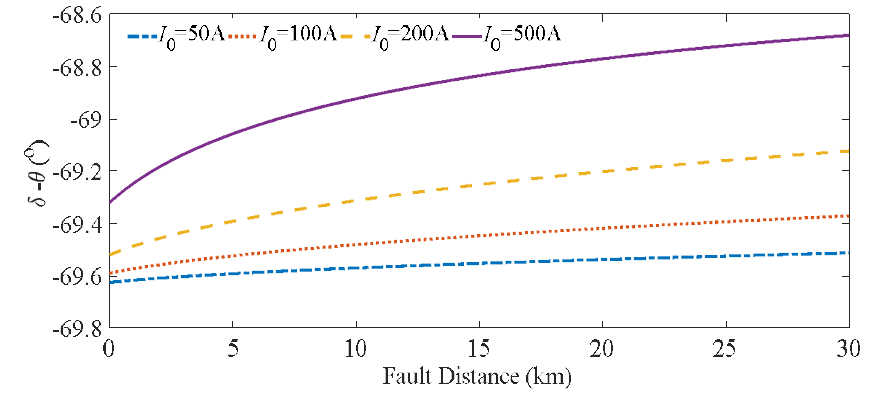
Figure 9. Influence of fault distance and initial current on the angle.